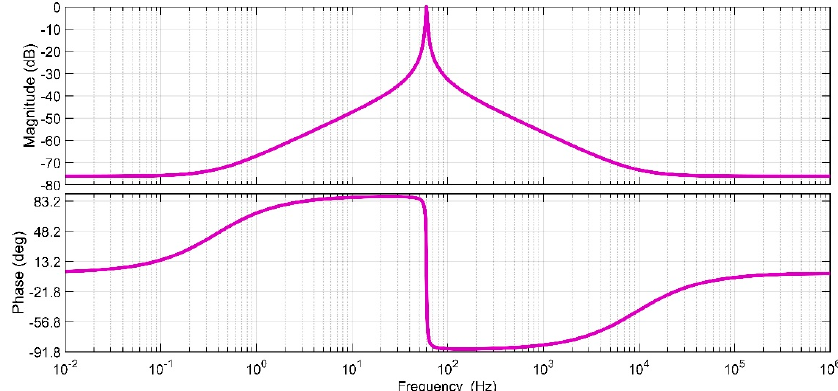
Appl. Sci. 2020 , 10 , x Figure 9. Phase and magnitude response of the resonant filter. Figure 9. Phase and magnitude response of the resonant filter.